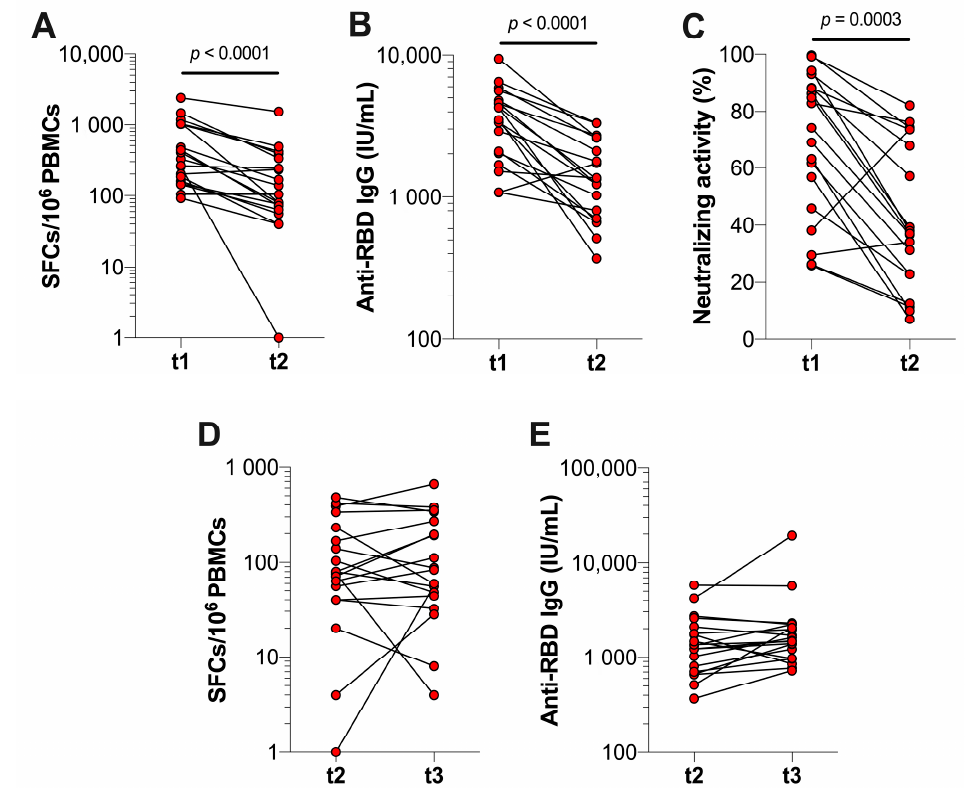
Figure 4. SARS-CoV-2-specific T cell and antibody responses of previously infected HCWs at t1, t2, and t3. Immune responses of previously infected HCWs were assessed median 27 (IQR 22–28) days (t1), 125 (IQR 118–126) days (t2), and 221 (IQR 204–213) days (t3) after receiving BNT162b2 or mRNA-1273 booster vaccination. ( A ) SARS-CoV-2 S1-specific T cell responses, ( B ) serum anti-RBD IgG concentrations, and ( C ) neutralizing activity against SARS-CoV-2 at t1 and t2 ( n = 19). ( D ) SARS-CoV-2 S1-specific and ( E ) serum anti-RBD IgG concentrations at t2 and t3 ( n = 19). Statistical significance was assessed with a Wilcoxon test.